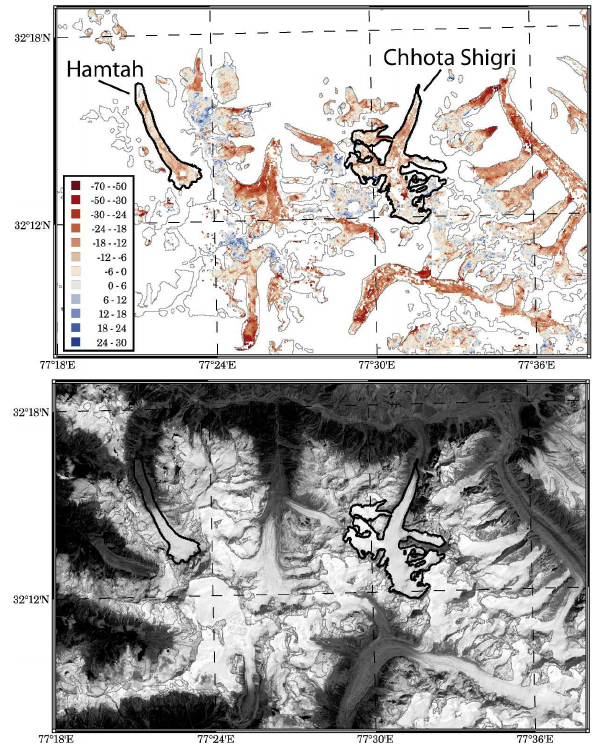
780 Fig. 5: Upper panel. Detail view of the elevation changes (m) on Chhota Shigri, Hamtah and 781 Fig. 5. Upper panel. Detail view of the elevation changes (m) on their neighbouring glaciers between February 2000 and October 2011. Lower panel: SPOT5 782 Chhota Shigri, Hamtah and their neighbouring glaciers between HRG image of the corresponding area acquired in October 2005. 783 February 2000 and October 2011. Lower panel: SPOT5 HRG image 784 of the corresponding area acquired in October 785